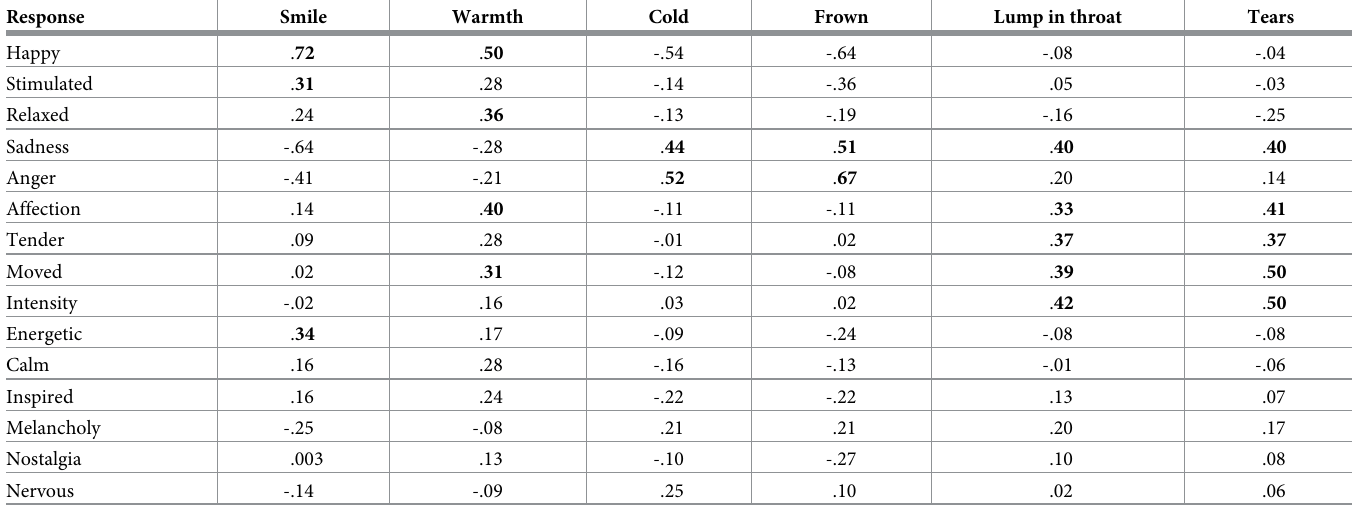
Table 3. Polyserial correlations between main bodily activity variables from MCA, and emotional descriptors (medium to large positive correlations in bold